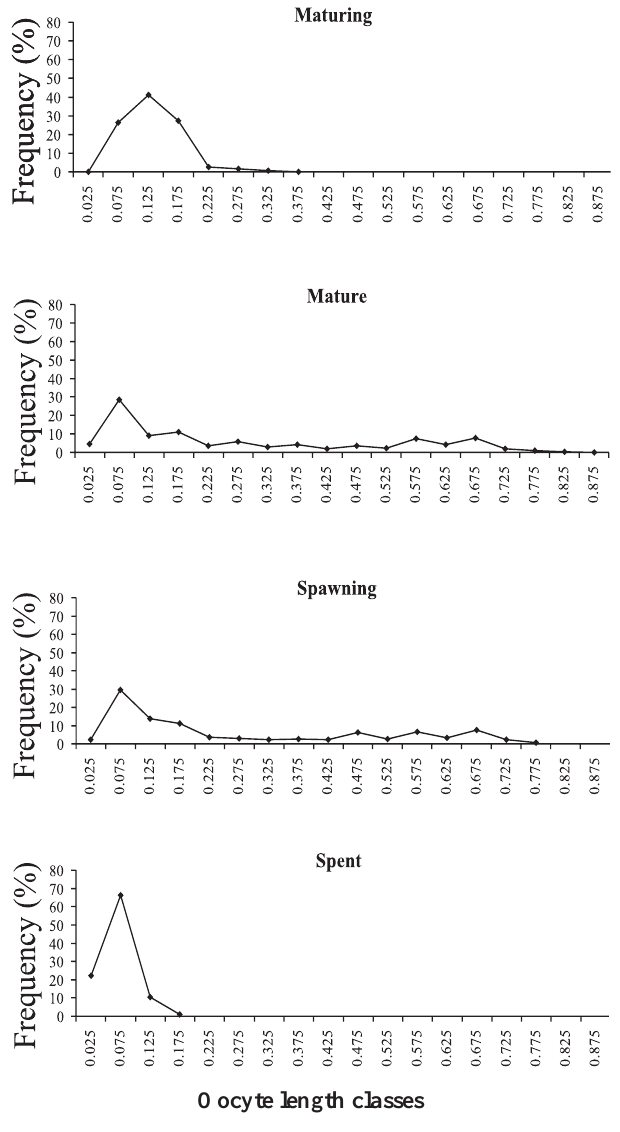
Fig. 3. Distribution of the relative frequencies of oocyte di- ameter classes in the different gonadal maturation stages in Bryconamericus iheringii from rio Vacacaí, RS, Brazil, be- tween April 2001 and March 2002. Number of analyzed go- nads in each stage: maturing (9), mature (6), spawning (8) and spent